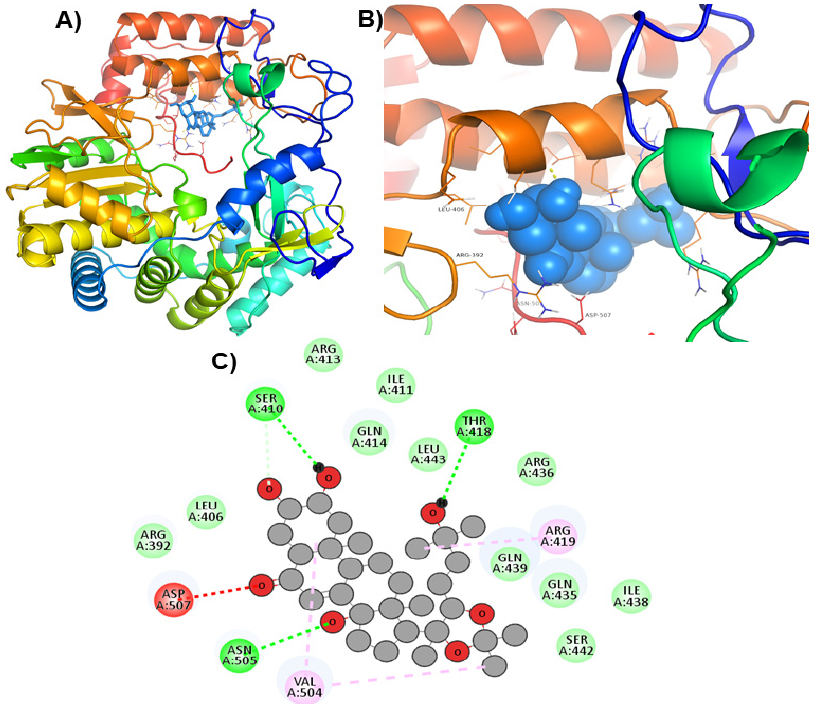
Figure 3. Visualization of ZINC69481850 in RdRp's active site. 3D views of whole protein and ligand interactions ( A ), 3D views of interacting residues of the RdRp active site with ZINC69481850 ( B ), and 2D views of the RdRp residue interacting with ZINC69481850 ( C ).